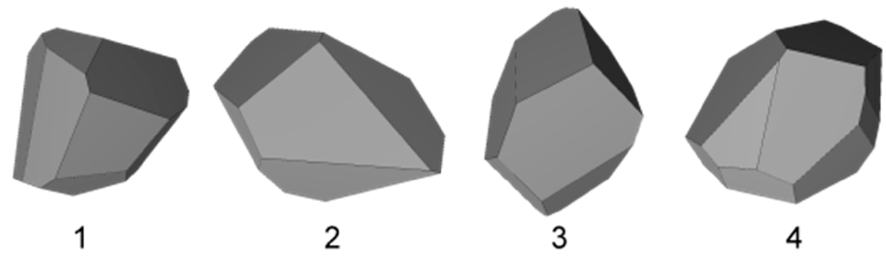
Figure 5. Other particle shapes used in calculations. In Figure 6 the scattering matrix is obtained for two particle sizes: D = 5 µ m (thin curves) and D = 20 µ m (thick curves).